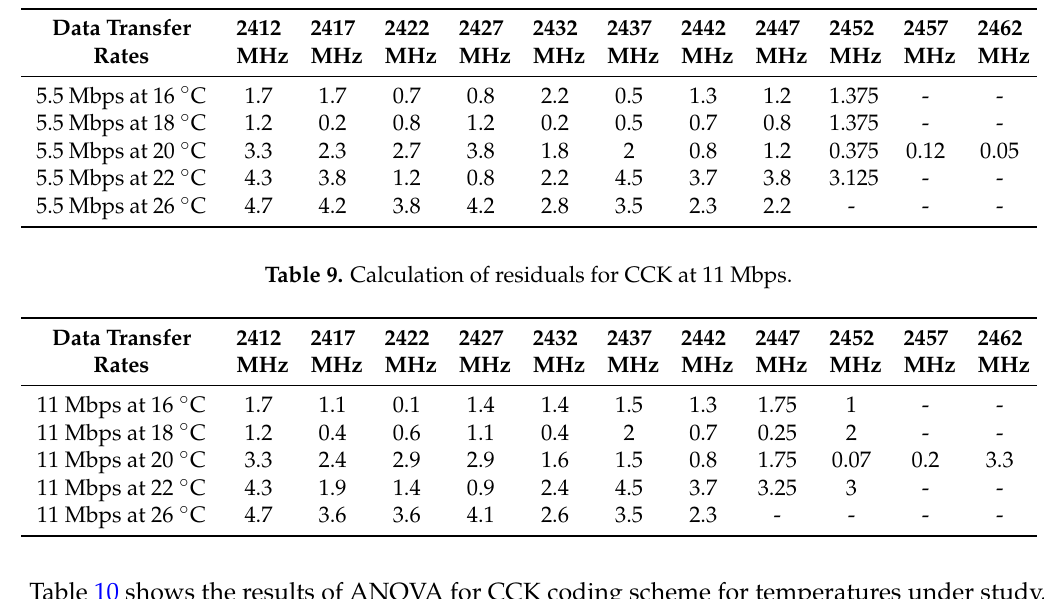
Table 8. Calculation of residuals for CCK at 5.5 Mbps.